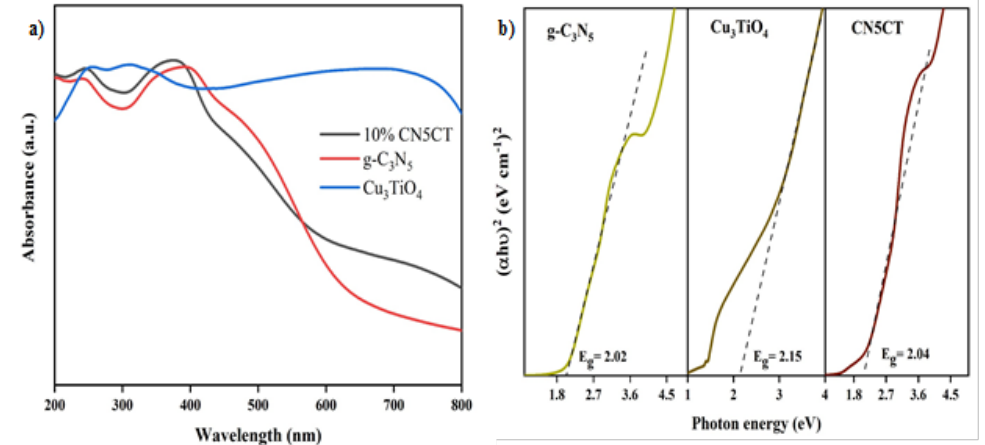
Figure 6. ( a ) UV-Vis DRS spectra and ( b ) bandgap plot.